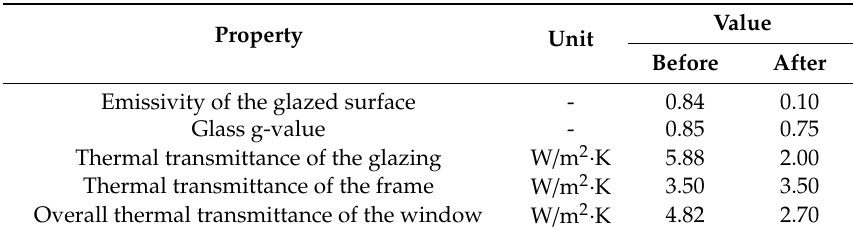
Table 6. Main thermophysical properties of the